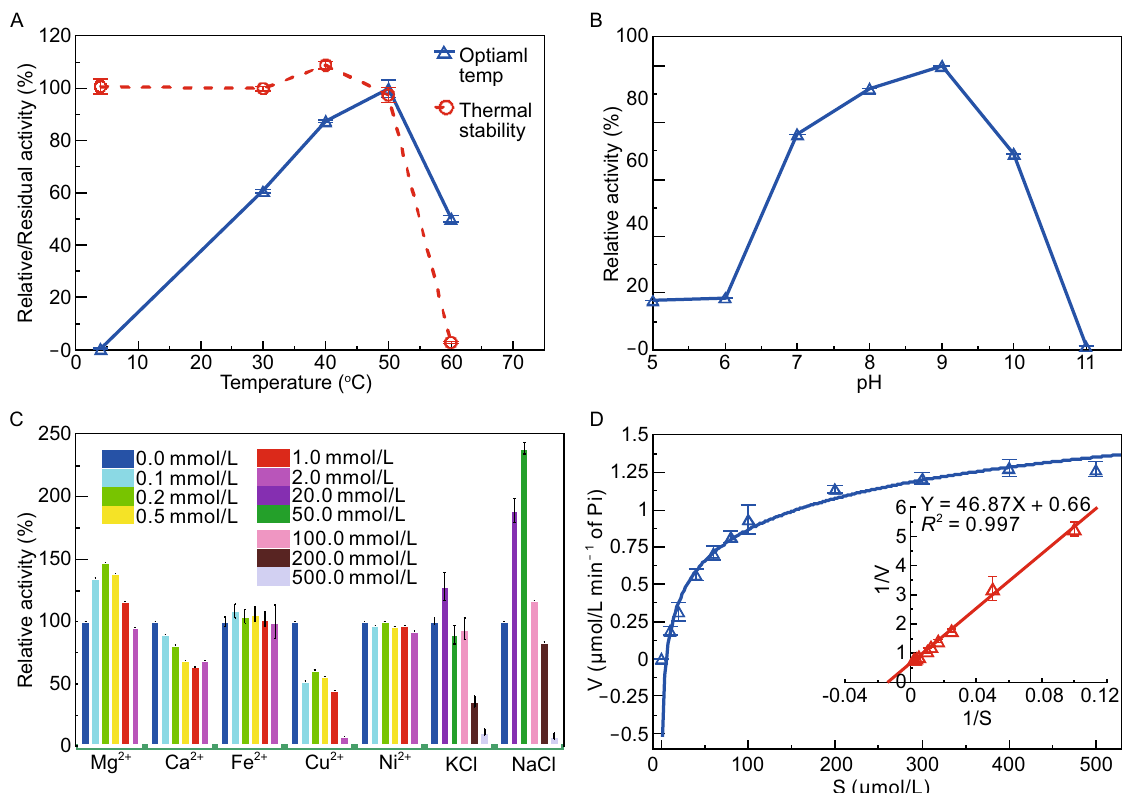
Figure 3. The biochemical properties of MamK ATPase activity. (A) The effect of temperature. The maximum enzyme activity and thermal stability were observed at 50°C and 40°C, respectively. (B) The effect of pH. More than 80% of MamK enzyme activity was retained within a pH range of 7.0 – 9.5, with maximum activity observed at pH 9.0. (C) The effects of various divalent cations and salts. Concentrations ranging from 0.1 to 1.0 mmol/L Mg 2+ and from 20 to 100 mmol/L NaCl signi fi cantly affected MamK ATPase activity. (D) The kinetic parameters assayed under different concentrations of ATP. The Michaelis constants Vmax and Km for the enzyme reaction were determined as the reciprocal of the absolute x-intercept and y-intercept, respectively, after plotting the reciprocal of the catalytic ef fi ciency (1/V) versus the reciprocal of the substrate